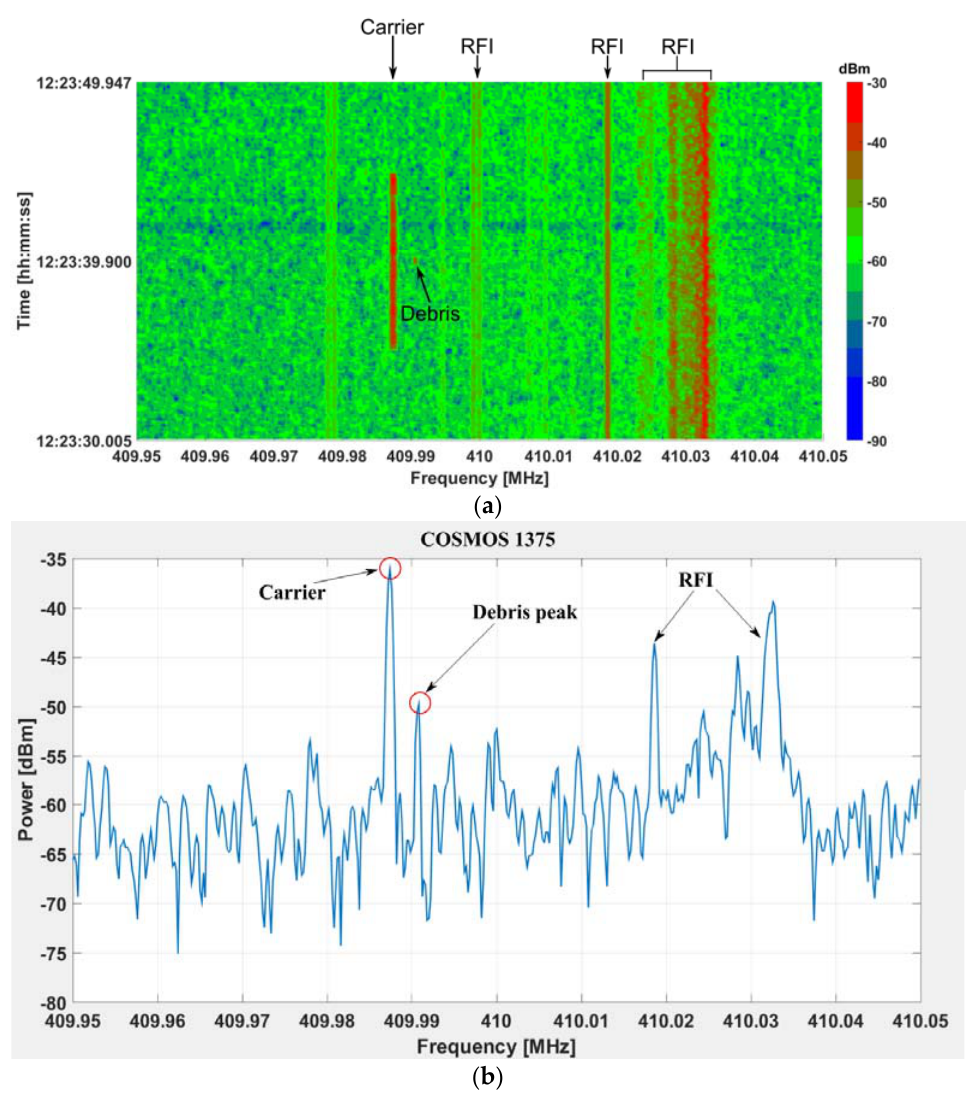
Figure 9. Debris COSMOS 1375: ( a ) spectrogram; ( b ) screenshot of the spectrum analyzer at the center of the visibility interval (Table 4).